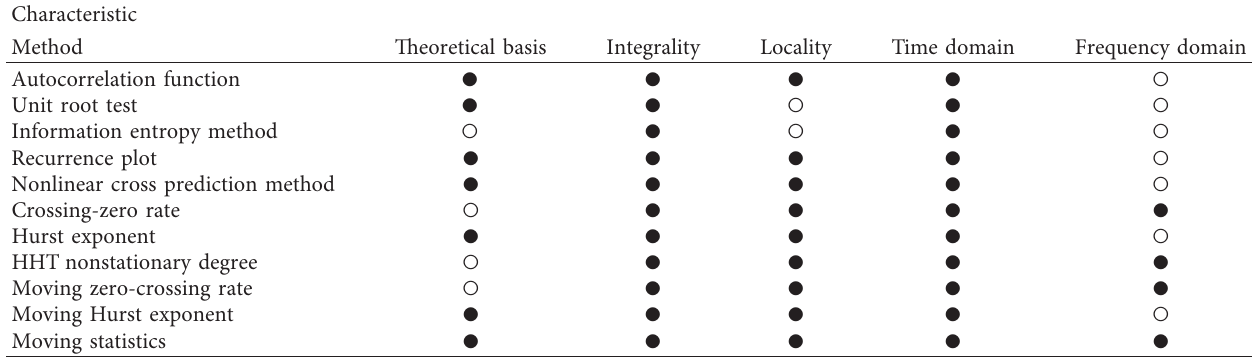
Table 1: Comparison of the applicable scope of the nonstationary degree evaluation method.